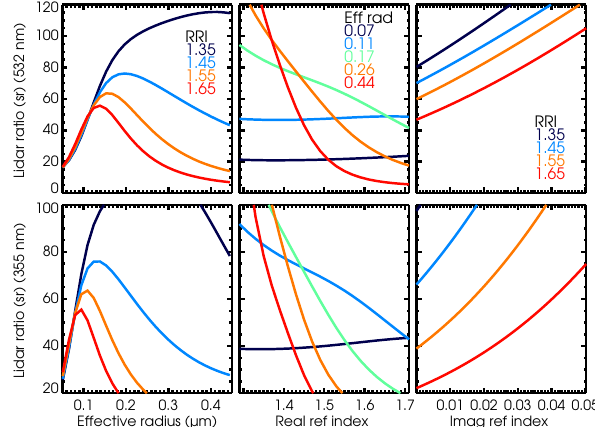
Figure 2. Like Fig. 1 but for 532nm lidar ratio (top row) and 355nm lidar ratio (bottom row).